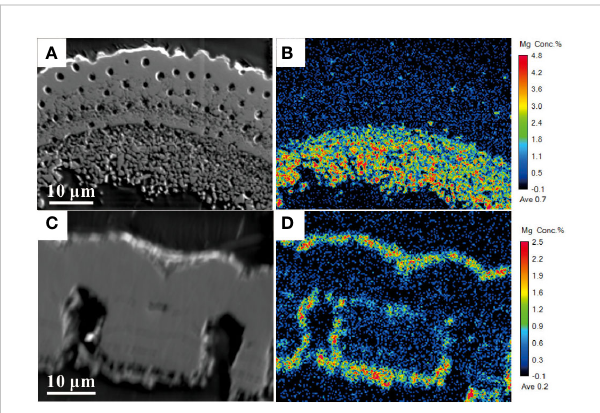
FIGURE 4 SEM images of foraminiferal wall cross-section and Mg (intensity) EPMA map of G menardii (A, B) and N. dutertrei (C, D)